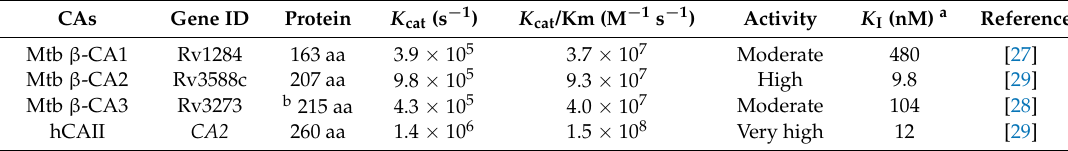
Table 1. Activity and inhibition properties of Mtb β -CAs compared to human CA